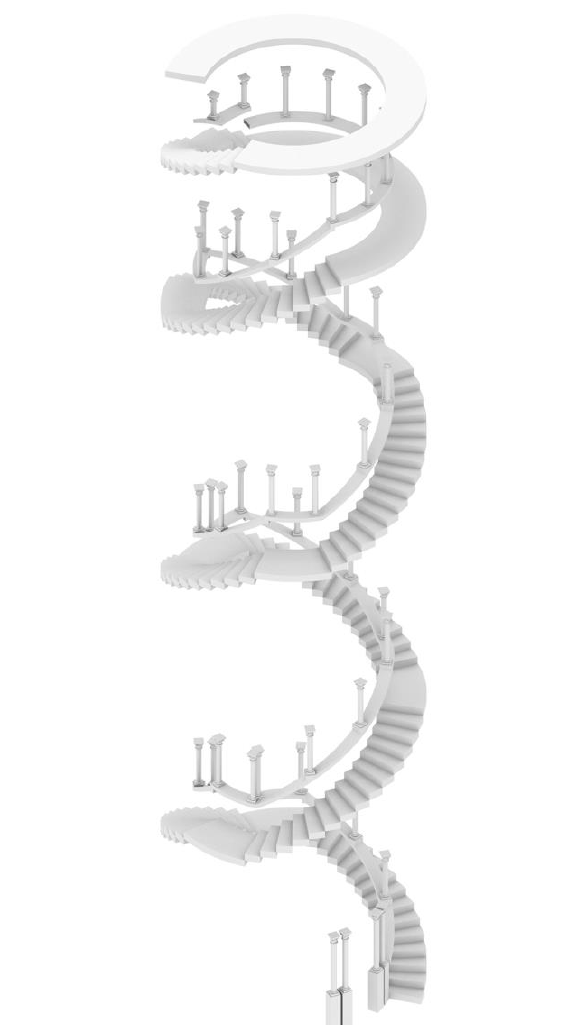
Figure 12 . The Quinta da Regaleira in Sintra, the Poço Iniciatico , digital model of the staircase and structures.